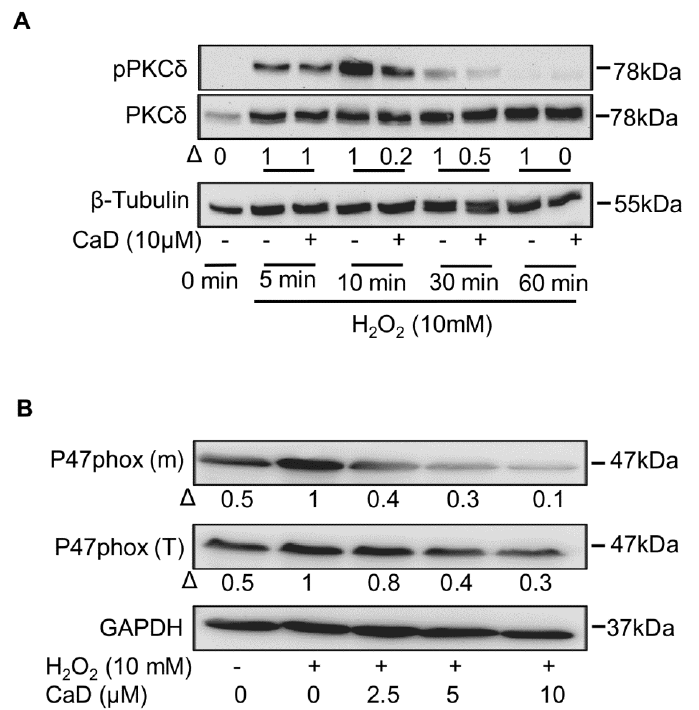
Figure 11. Effect of CaD on H 2 0 2 -activated PKC δ and NADPH oxidase. THP-1 monocytes were pretreated with various CaD concentrations for 1 h, followed by H 2 0 2 (10 mmol/L) for different time points ( A ) or 24 h ( B ). Phosphorylation of PKC δ , and activation and membrane translocation of p47phox were measured by Western blotting. Δ , fold-change nor- malized to H 2 0 2 only. One representative image of at least three independent experiments is